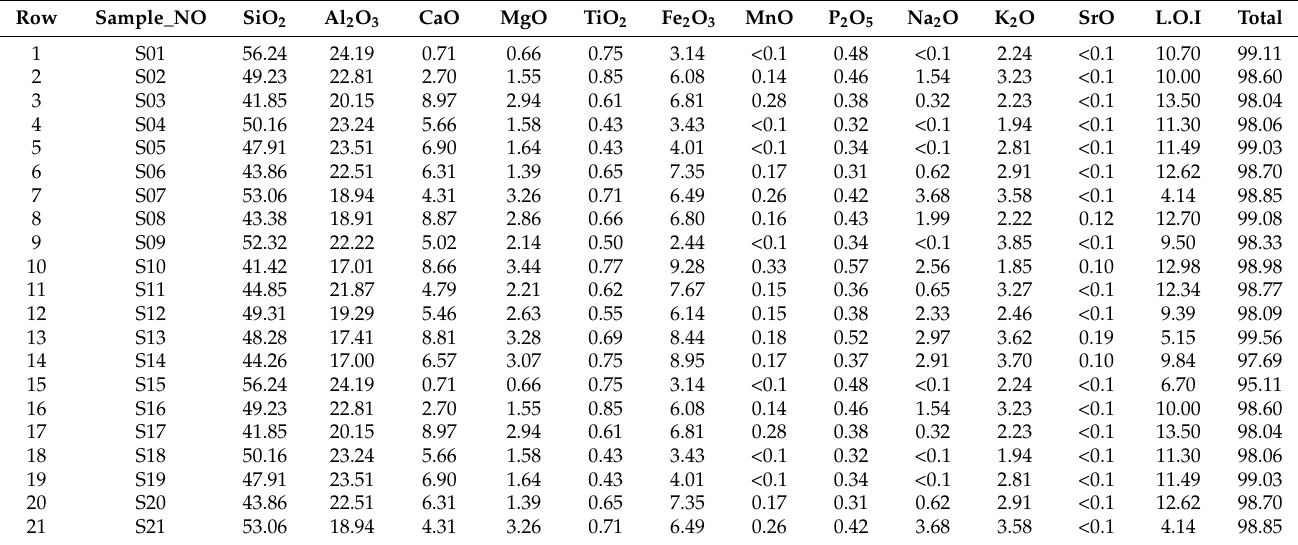
Table A2. XRF analysis results of some main oxides (Oxides unit: percent). L.O.I: Loss Of Ignition.